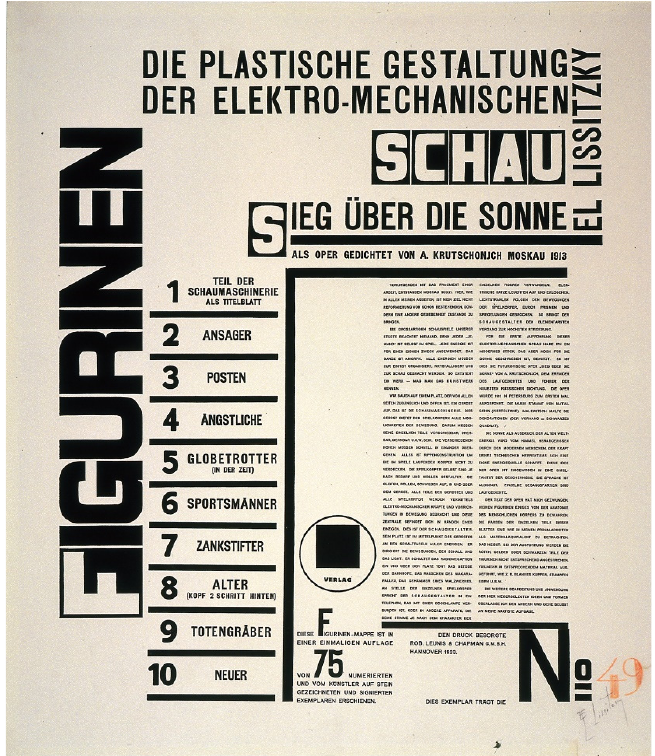
Figure 2. El Lissitzky, Introductory leaflet for the ‘Figurinnenmappe’, 1923. Van Abbemuseum. Photo: Peter Cox.